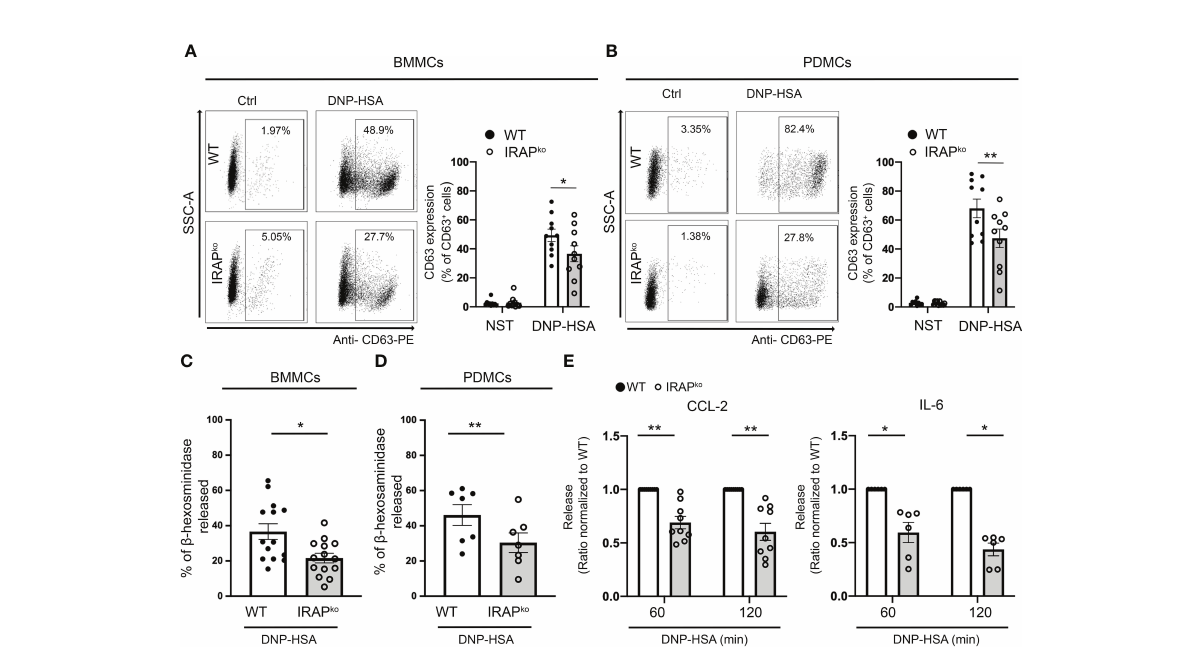
FIGURE 2 IRAP-de fi cient mice exhibit a diminished degranulation response and cytokine/chemokine production in BMMCs and PDMCs. WT and IRAP- de fi cient (IRAP KO ) BMMCs (A, C) and PDMCs (B, D) were sensitized with anti-DNP IgE. (A, B) Degranulation was monitored by fl ow cytometry determining CD63 expression (% expression is indicated) as a surrogate marker of mast cell degranulation 10 min after addition of PBS (basal expression) or antigen (30 ng/mL of DNP-HSA). A representative experiment (left panel) and the quantitative analysis of indicated number of experiments are shown (right panel). (C, D) Degranulation was also determined by measuring the net release of the granular enzyme b - hexosaminidase in BMMCs and PDMCs after stimulation with IgE/Ag for 45 minutes in indicated number of experiments. (E) IgE-sensitized BMMCs were also evaluated for their ability to secrete CCL2 and IL6 after stimulation with IgE/Ag for 60 and 120 min as indicated. Data shown in (A – D) are the mean ± s.e.m of indicated experiments. Statistical analysis was done using an unpaired Student ’ s t test. Data in (E) have been normalized by setting WT values to 1. The range of maximal release was between 2,3 to 83,2 ng/mL for CCL-2 and 61,7 to 3781 pg/mL for IL-6. Statistical analysis was done using a Wilcoxon Test. No differences in basal secretion in the absence of Ag was noted between the